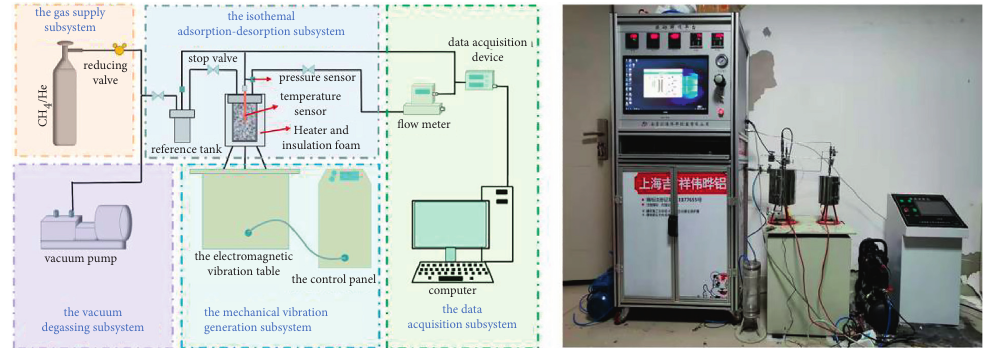
Figure 2: Schematic diagram of MVGAD-I experimental